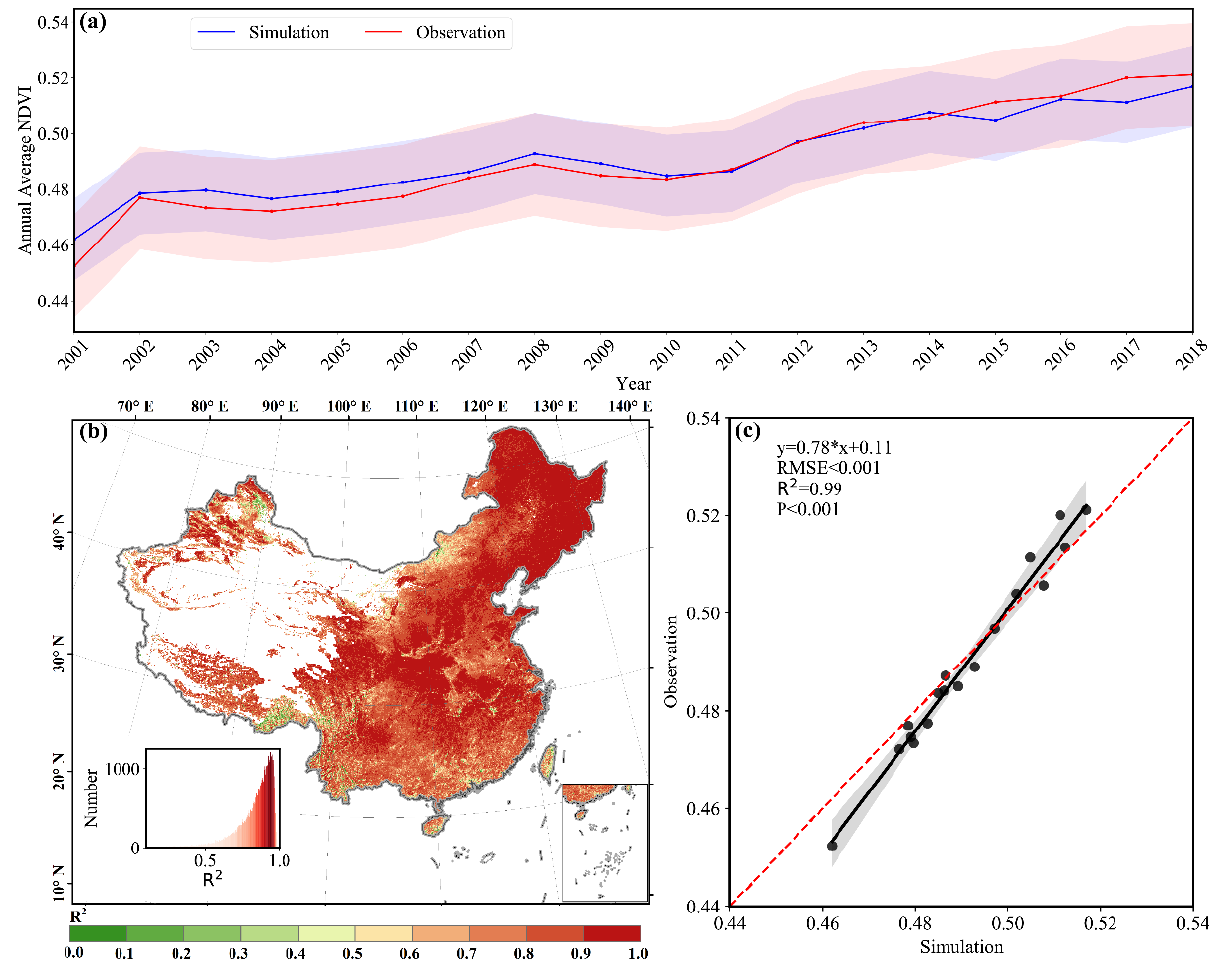
Figure 3. Comparisons between the predicted and satellite-derived NDVI showing the ( a ) interannual variability over the entire study area, ( b ) coefficient of determination (R 2 ), and ( c ) the relationship between predicted and satellite-derived NDVI.